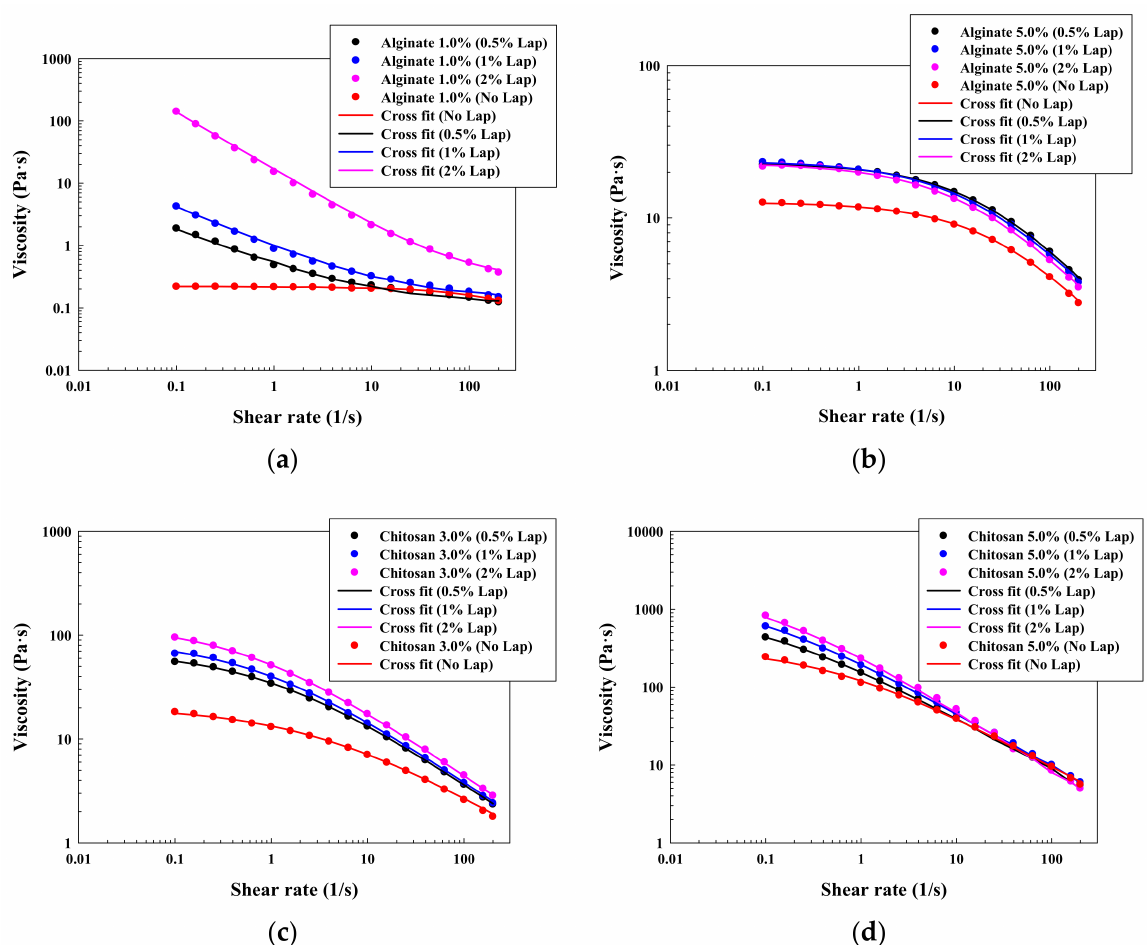
Figure 2. Viscosity-shear rate plots for different polysaccharides solutions with Laponite: ( a ) alginate 1.0% w / w ; ( b ) alginate 5.0% w / w ; ( c ) chitosan 3.0% w / w ; ( d ) chitosan 5.0% w / w .